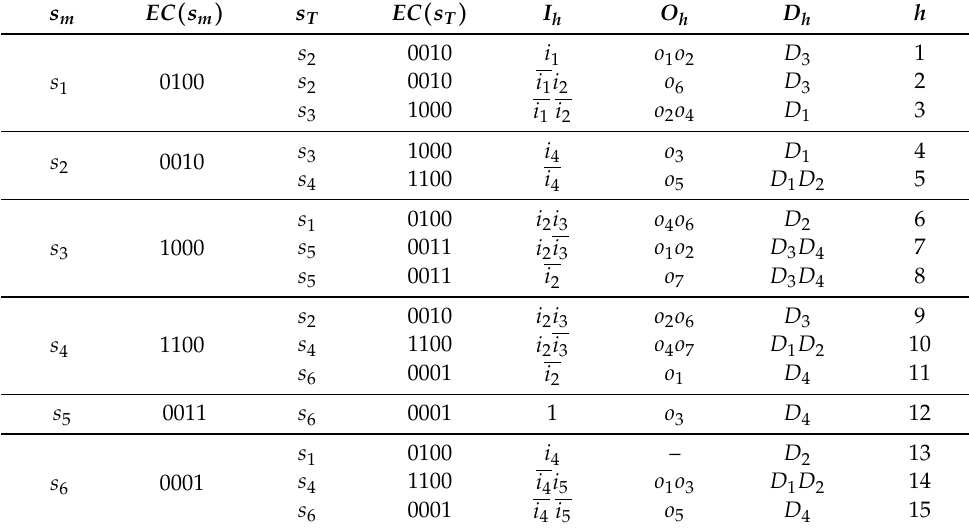
Table 2. DST of P E FSM A 0